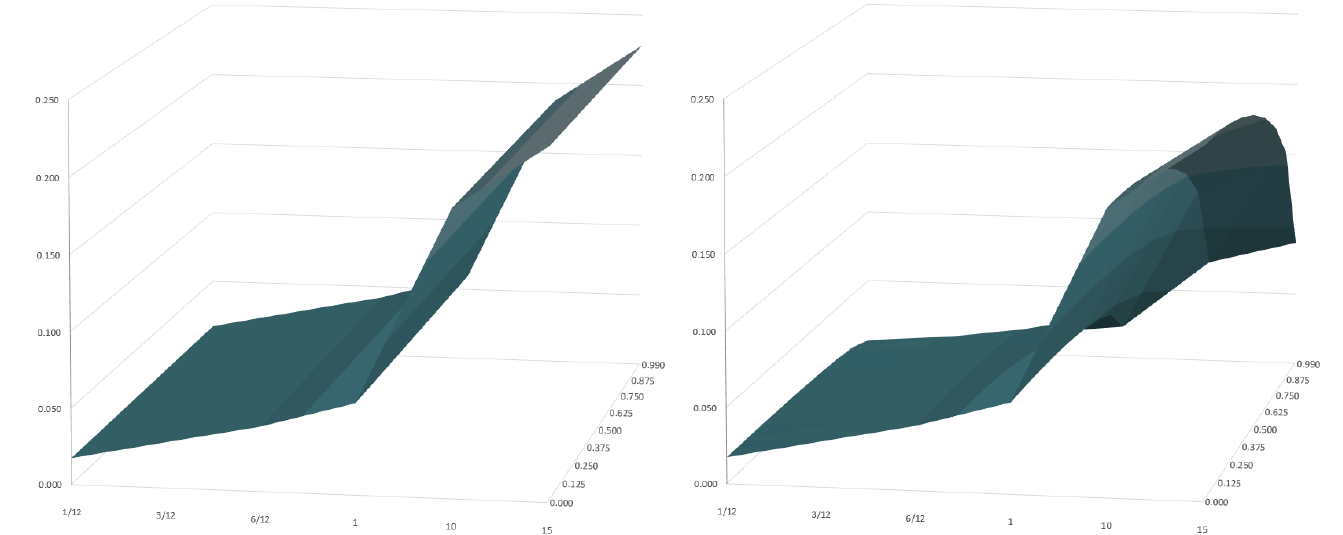
Figure 4. Surfaces of European ATM call (or put) prices ( z -axis) in the reference frames L ( left figure ) and L (cid:48) ( right figure ), for velocities ranging from 0.0% c to 99% c ( y -axis) and maturities T ( x -axis) of 1/12, 3/12, 6/12, 1, 10 and 15 years. The asset volatility is fixed at σ = 15%. For simplicity, we consider the values at inception t = 0 and r = 0% and both prices at inception and strike equal to one S = K = 1.